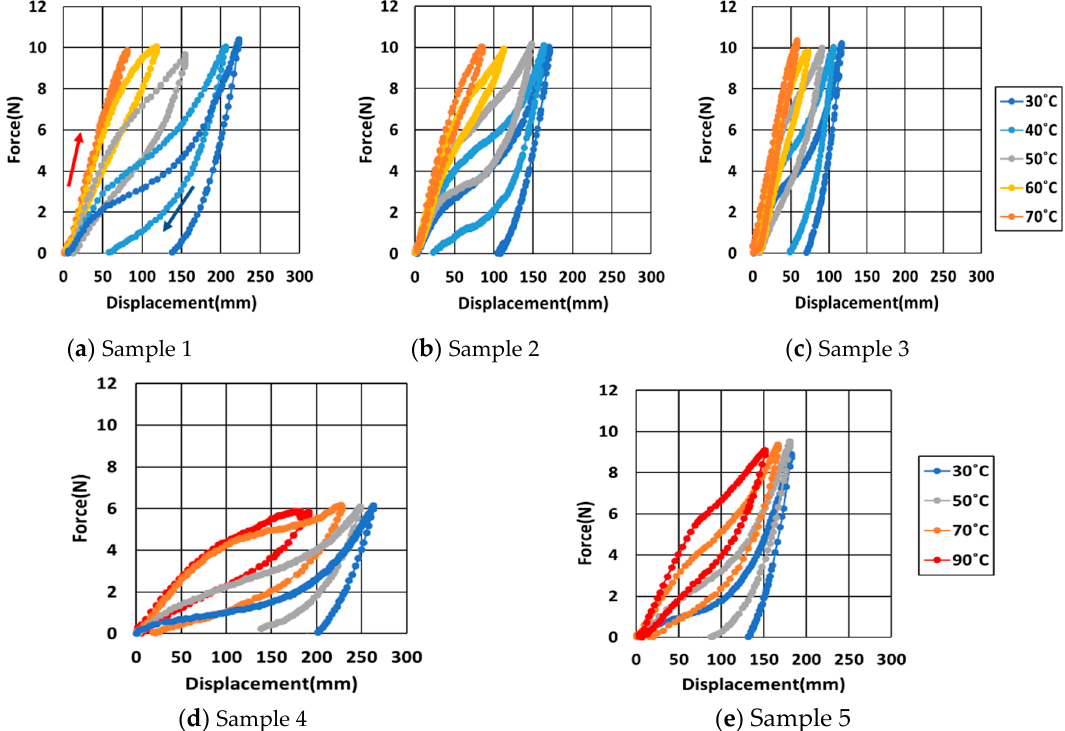
Figure 4. The force-displacement relationship with various temperature, ( a ) sample No. 1, ( b ) sample No. 2, ( c ) sample No. 3, ( d ) sample No. 4, and ( e ) sample No. 5, from Table 1.